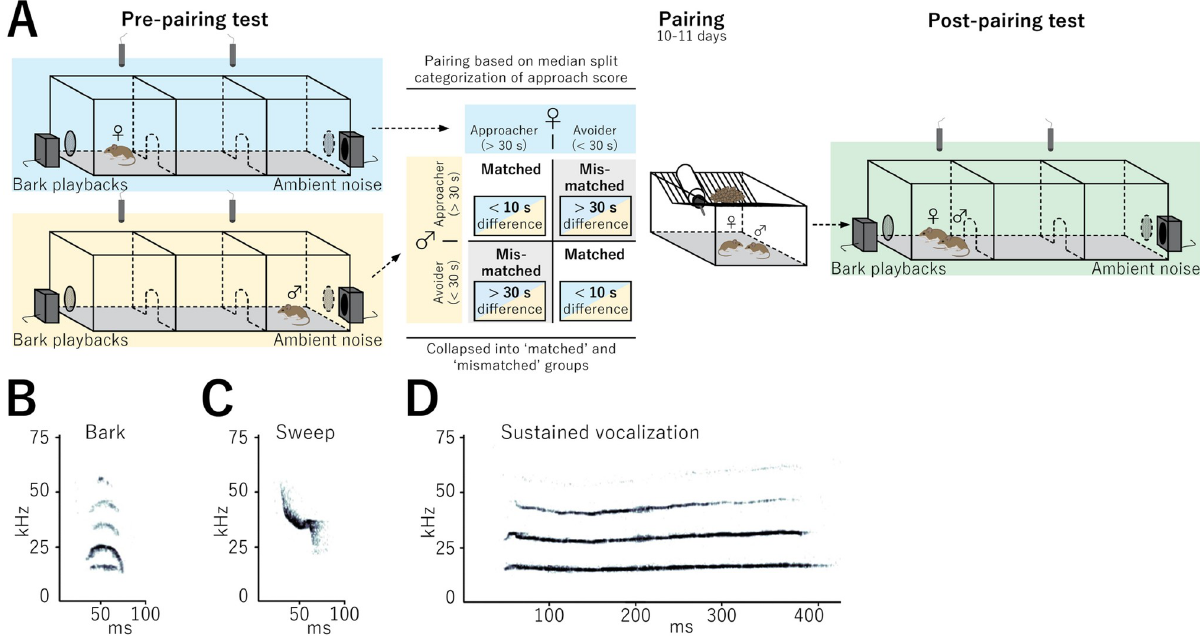
Fig 1. Overview of experimental design. A . Male and female mice were first tested individually for their response to bark playbacks. Based on their response they were paired using a 2 x 2 factorial design using level of approach and sex as factors. After 10–11 days post pairing, the pairs were tested again for their response as a dyad. Spectrograms showing the acoustic characteristics of B) Barks, C) Sweeps and D) Sustained vocalizations.